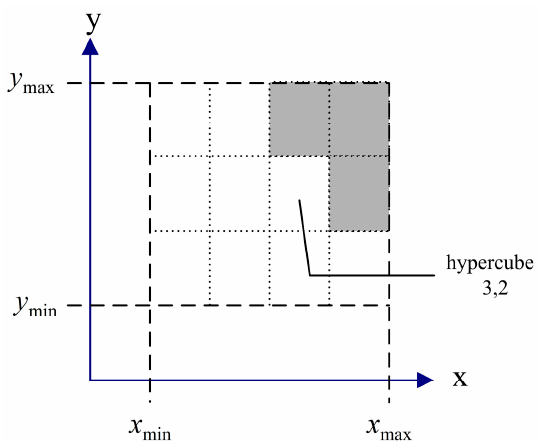
Figure 5. Hypercube.